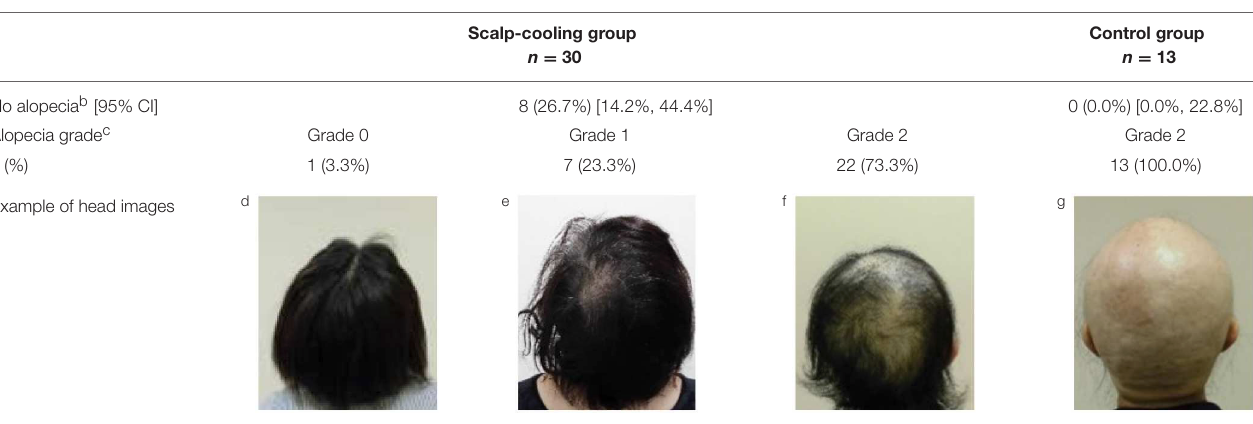
TABLE 2 | CTCAE evaluation of alopecia following chemotherapy (PP population a